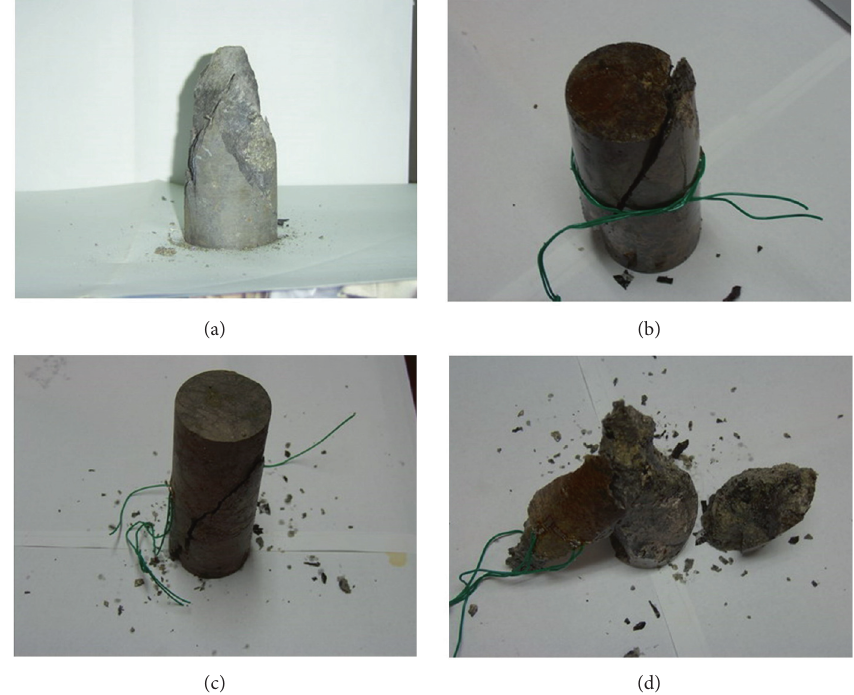
Figure 1: Fracture patterns of mineralized limestone under confining pressure of (a) 0MPa, (b) 10MPa, (c) 15MPa, and (d)